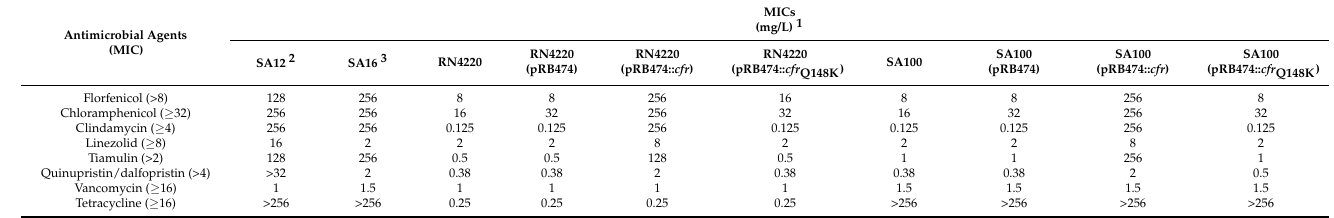
Table 3. PhLOPS A resistance phenotypes of cfr -carrying staphylococci and transformants.